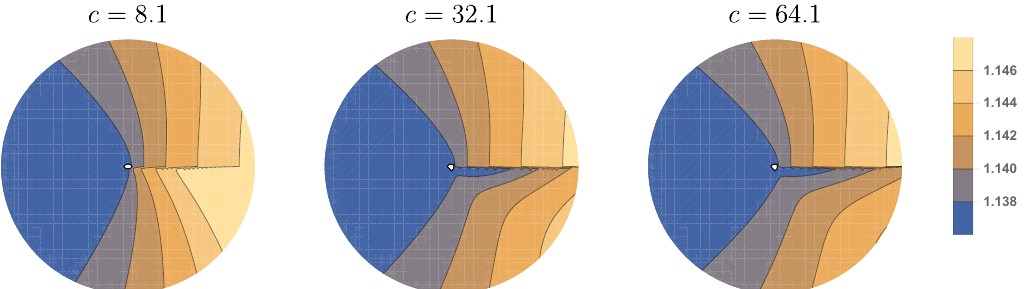
exact Figure 6 . These are plots of for h L = 0 : 01 ; h H =c = 100 but with di(cid:11)erent values of c . 0 j jV These are plotted in the same region and use the same range as (cid:12)gure 5 for ease of comparison. These results have converged to better than 10 (cid:0) 10 accuracy except for a tiny region at the origin of the disk (i.e. the white point at the center).